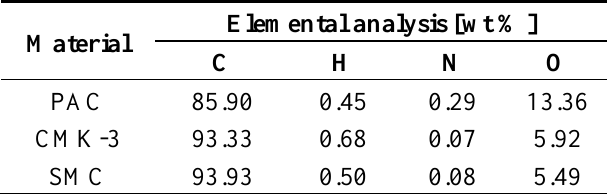
Figure 3. Transmission electron microscope (TEM) images of CMK-3 ( a ) and SMC ( b ). Table 2. Elemental composition of the three carbon